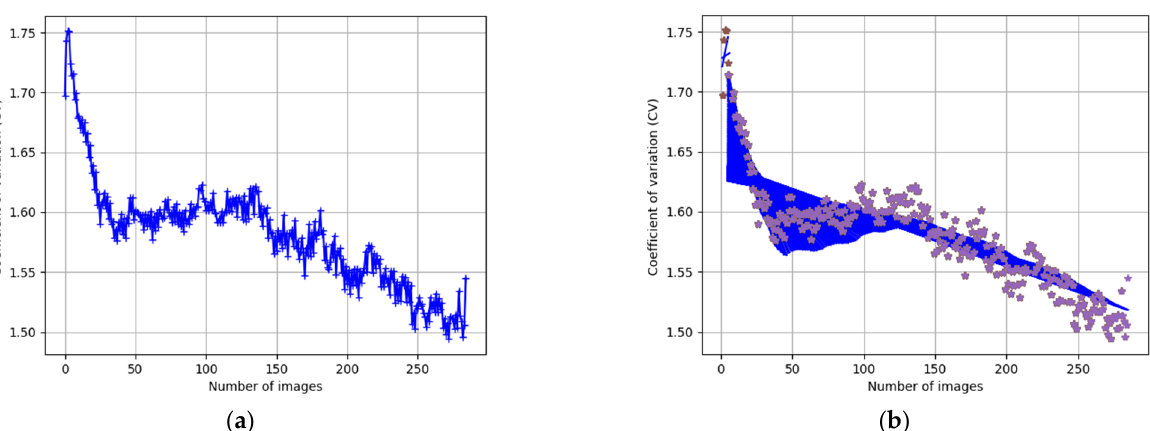
Figure 6. Dataset-1 with CPT for inducing apoptosis from confluency stage. ( a ) Evolution of CV in